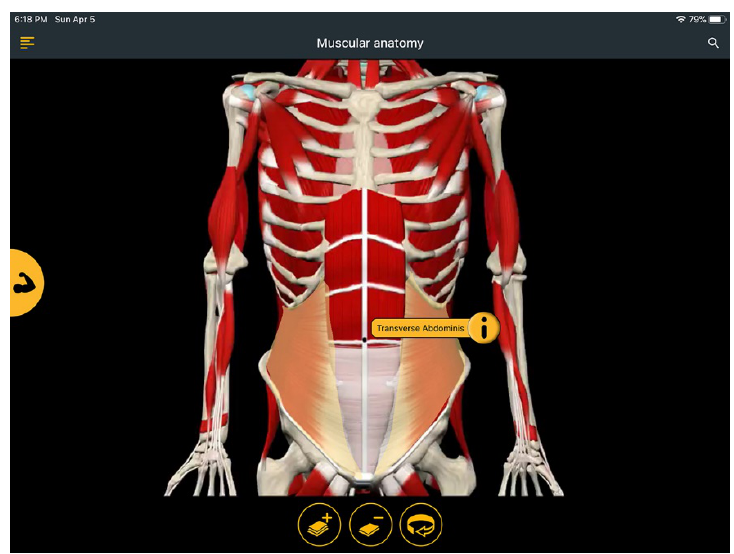
Figure 2 Screenshot of a body image in